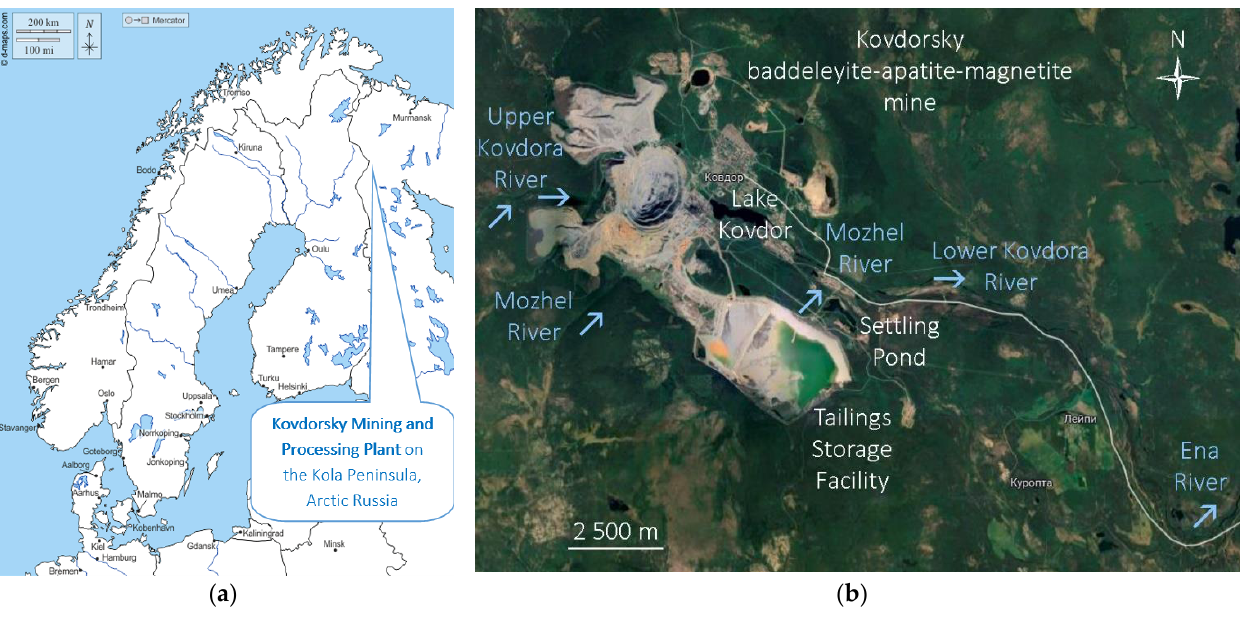
Figure 1. Study area: ( a ) the Kovdor deposit in Murmansk Oblast (based on the free blank map, d-maps.com); ( b ) mineral processing waste after the production of iron ore, apatite, and baddeleyite concentrates, southwards of the open pit mine and Lake Kovdor (based on a Google Earth image). The studied Upper Kovdora, Lower Kovdora, and Mozhel rivers (Table 1) belong to